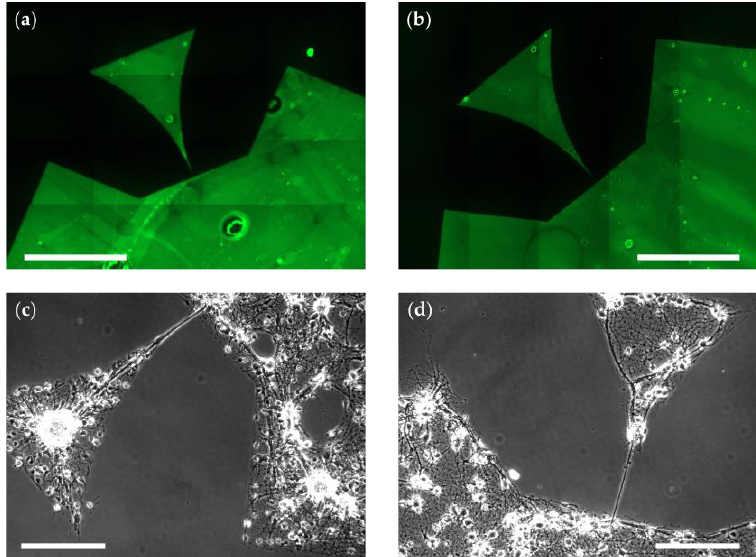
Figure 5. Patterning on glass with deposited Glymo. ( a , b ) Fluorescence micrographs of microcontact printed, patterned PLL-FITC (green) on glass with deposited Glymo, bathed in DDA (after µ CP), and washed three times with EtOH ( a ) or only washed with EtOH ( b ). Scale bars: 500 µ m. ( c , d ) Phase contrast micrographs of neurons growing within patterns on glass treated as in ( a ) ( c ; DIV 14) or glass treated as in ( b ) ( d ; DIV 14). Scale bars: 100 µ m.